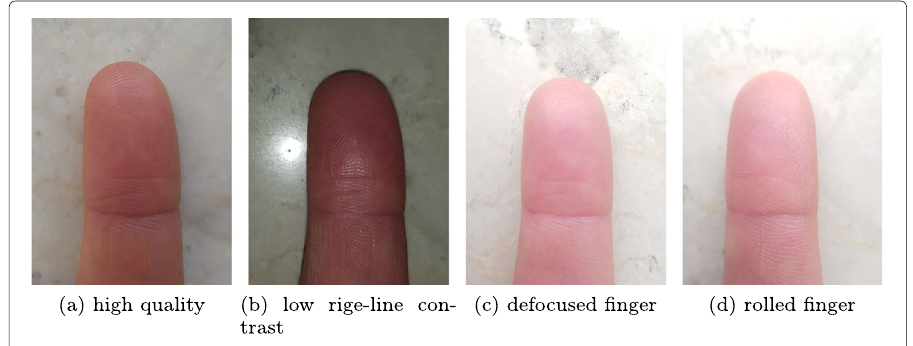
Fig. 5 Finger image quality. Example images of a high-quality finger image and three low-quality finger images captured by a Samsung Galaxy S8